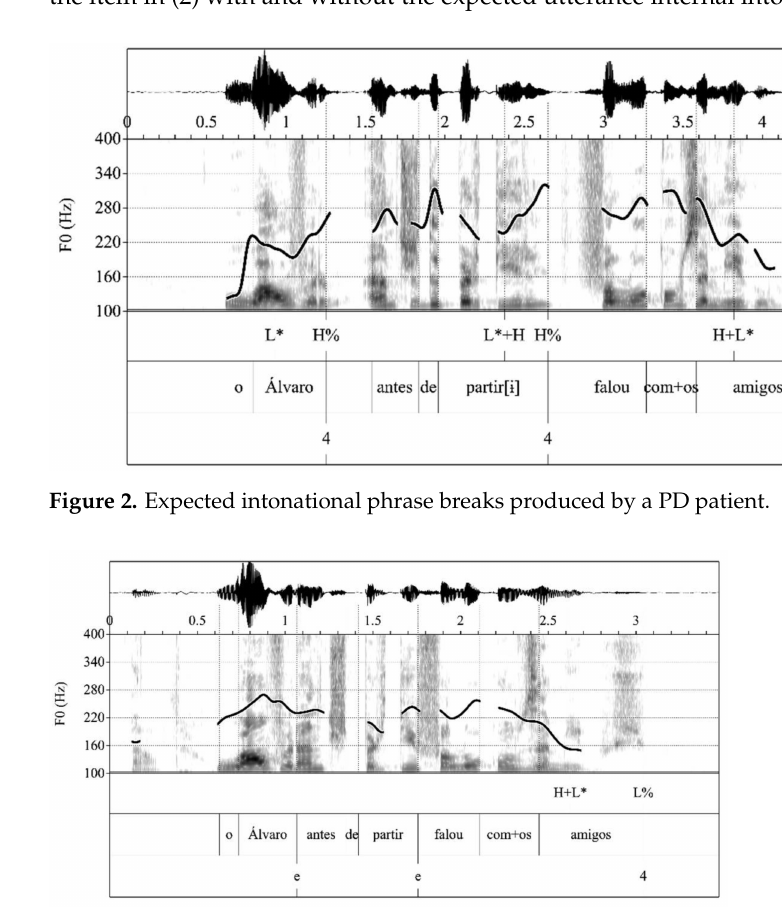
Figure 3. Expected intonational phrase breaks not produced by a PD